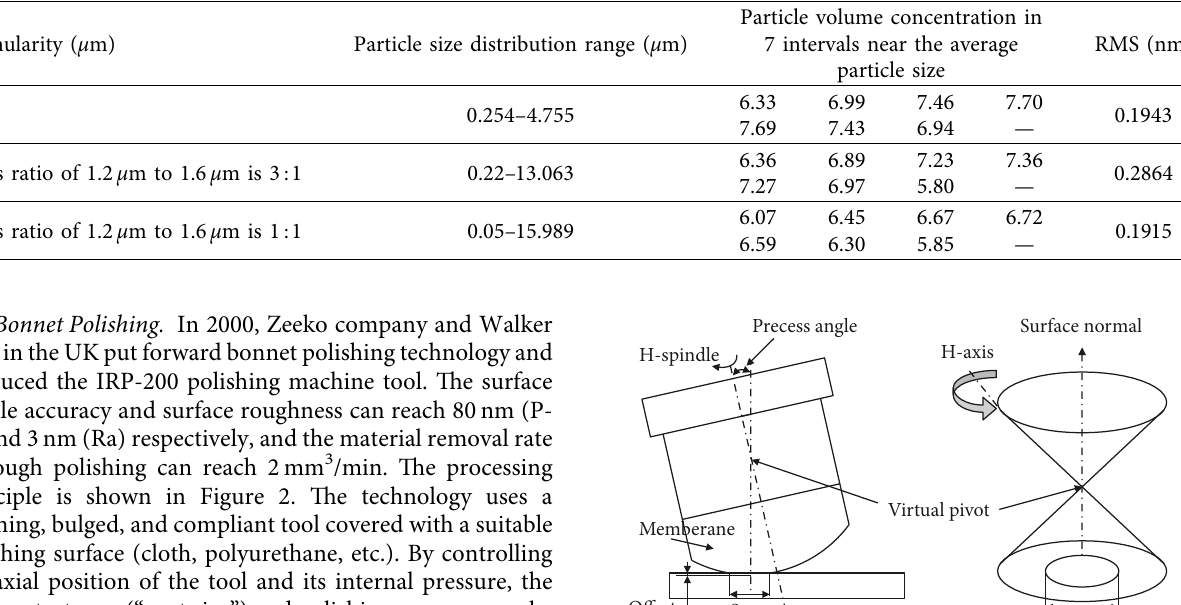
Table 1: 1.2 μ m particle size distribution range with different mass ratios and its corresponding workpiece surface roughness values after polishing.